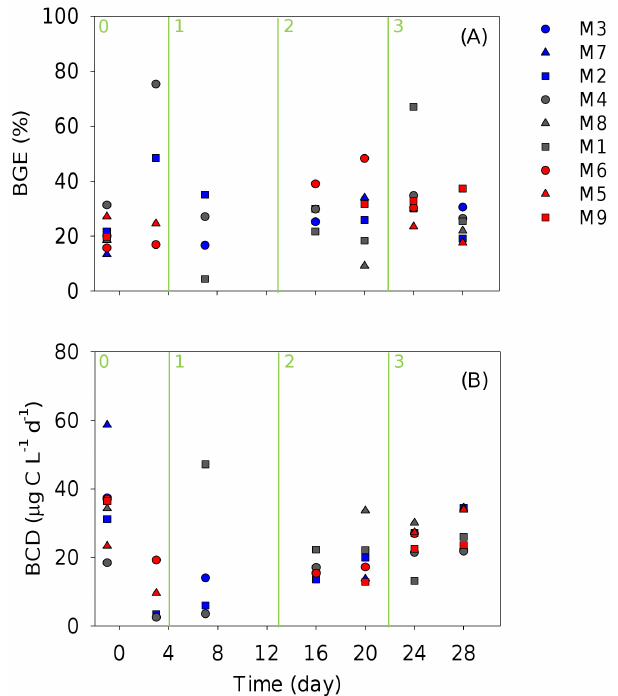
Fig. 4. Temporal variation of bacterial growth efficiency (A) and bacterial carbon demand (B) . For colour and symbol coding, see Fig. 1.